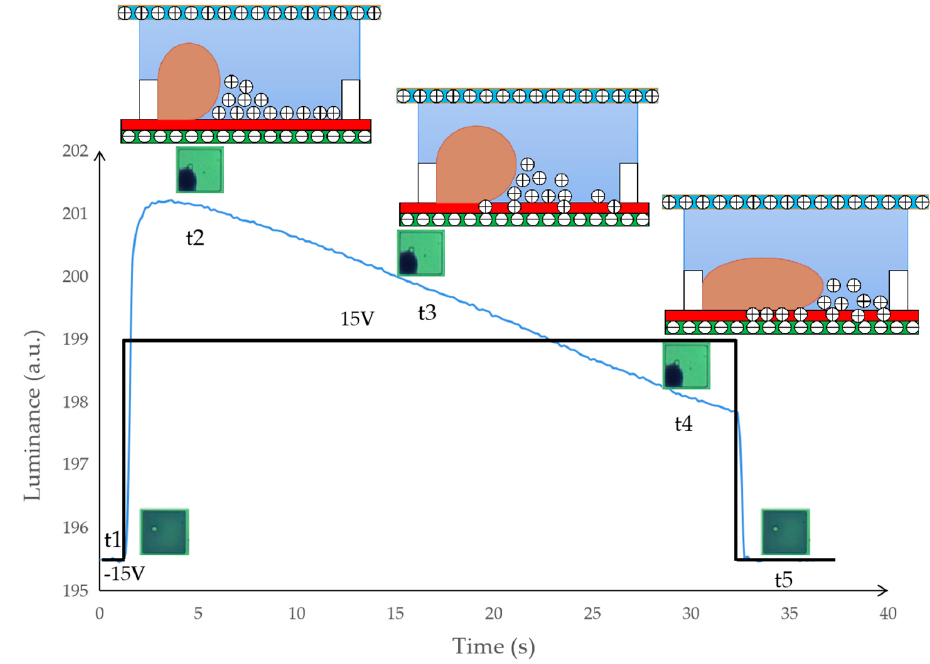
Figure 3. The illustration of oil backflow behavior in EWDs. The intensity curve of the reflected light when the pixel is turned on continuously for 30 s. The pixel is turned off at t1, the pixel is turned on at t2, the charge is embedded in the dielectric layer at t3, and the oil reaches an equilibrium state at t4.